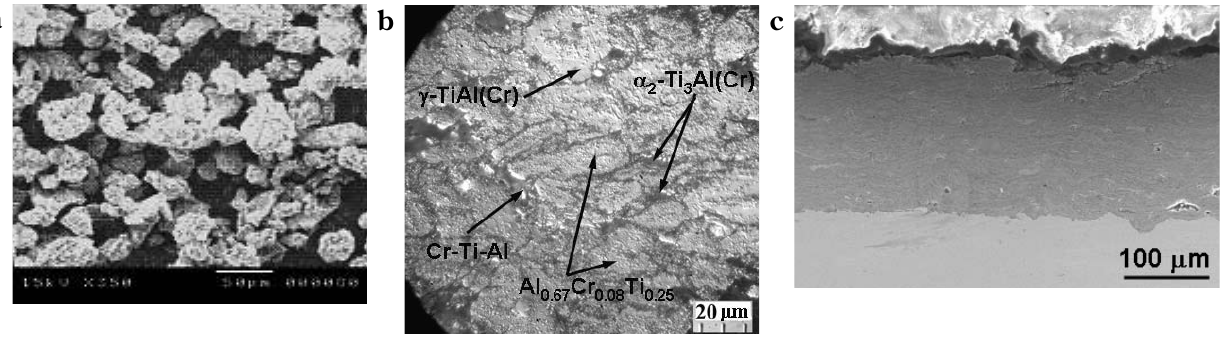
Fig.6 Morphology (a) and cross-section (b) of TiAlCr powder; cross-section of detonation spray coating from the powder (c).